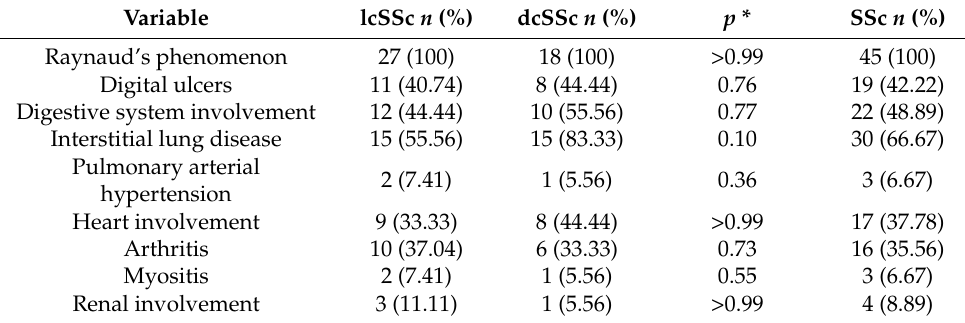
Table 2. Clinical manifestation in SSc patients.